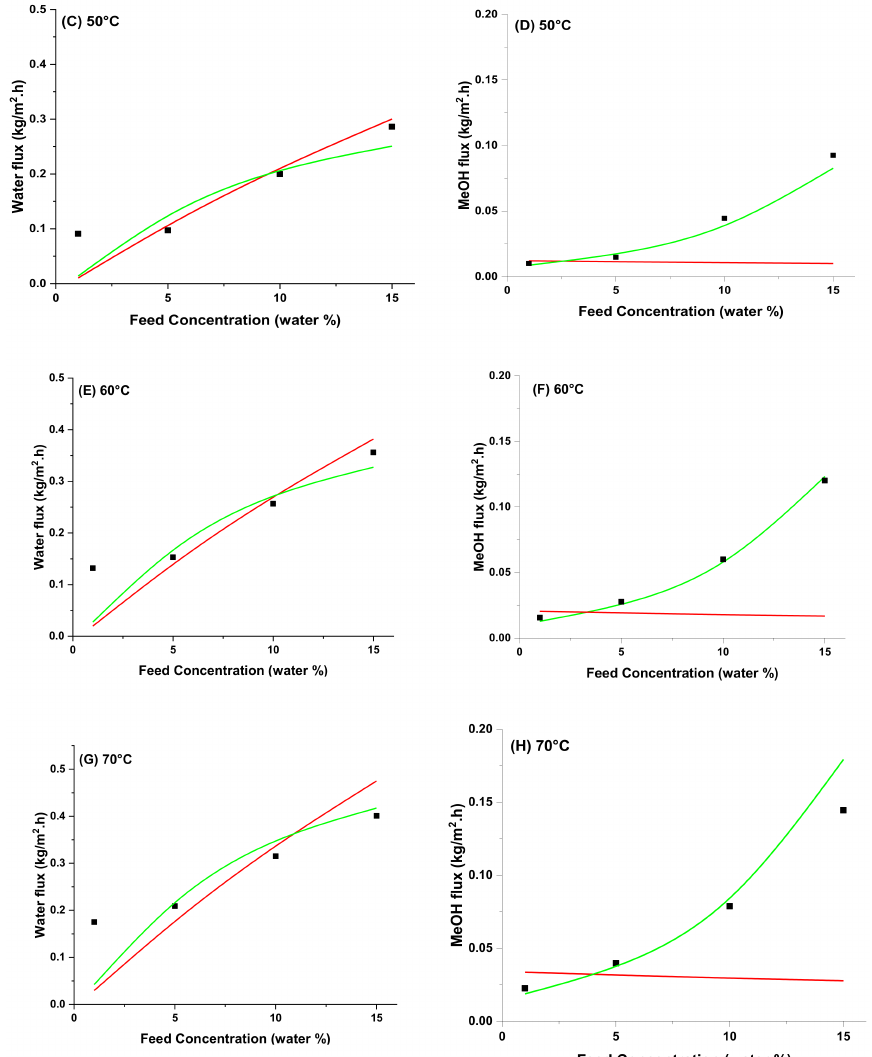
Figure 6. Comparison between measured partial fluxes ( (cid:4) ) calculated from Model I ( Red ) and Model II ( Green ); ( A , C , E , G ) water fluxes, and ( B , D , F , H ) methanol fluxes as a function of feed water concentration using PVA10 MMM at operating temperature of 40 − 70 ◦